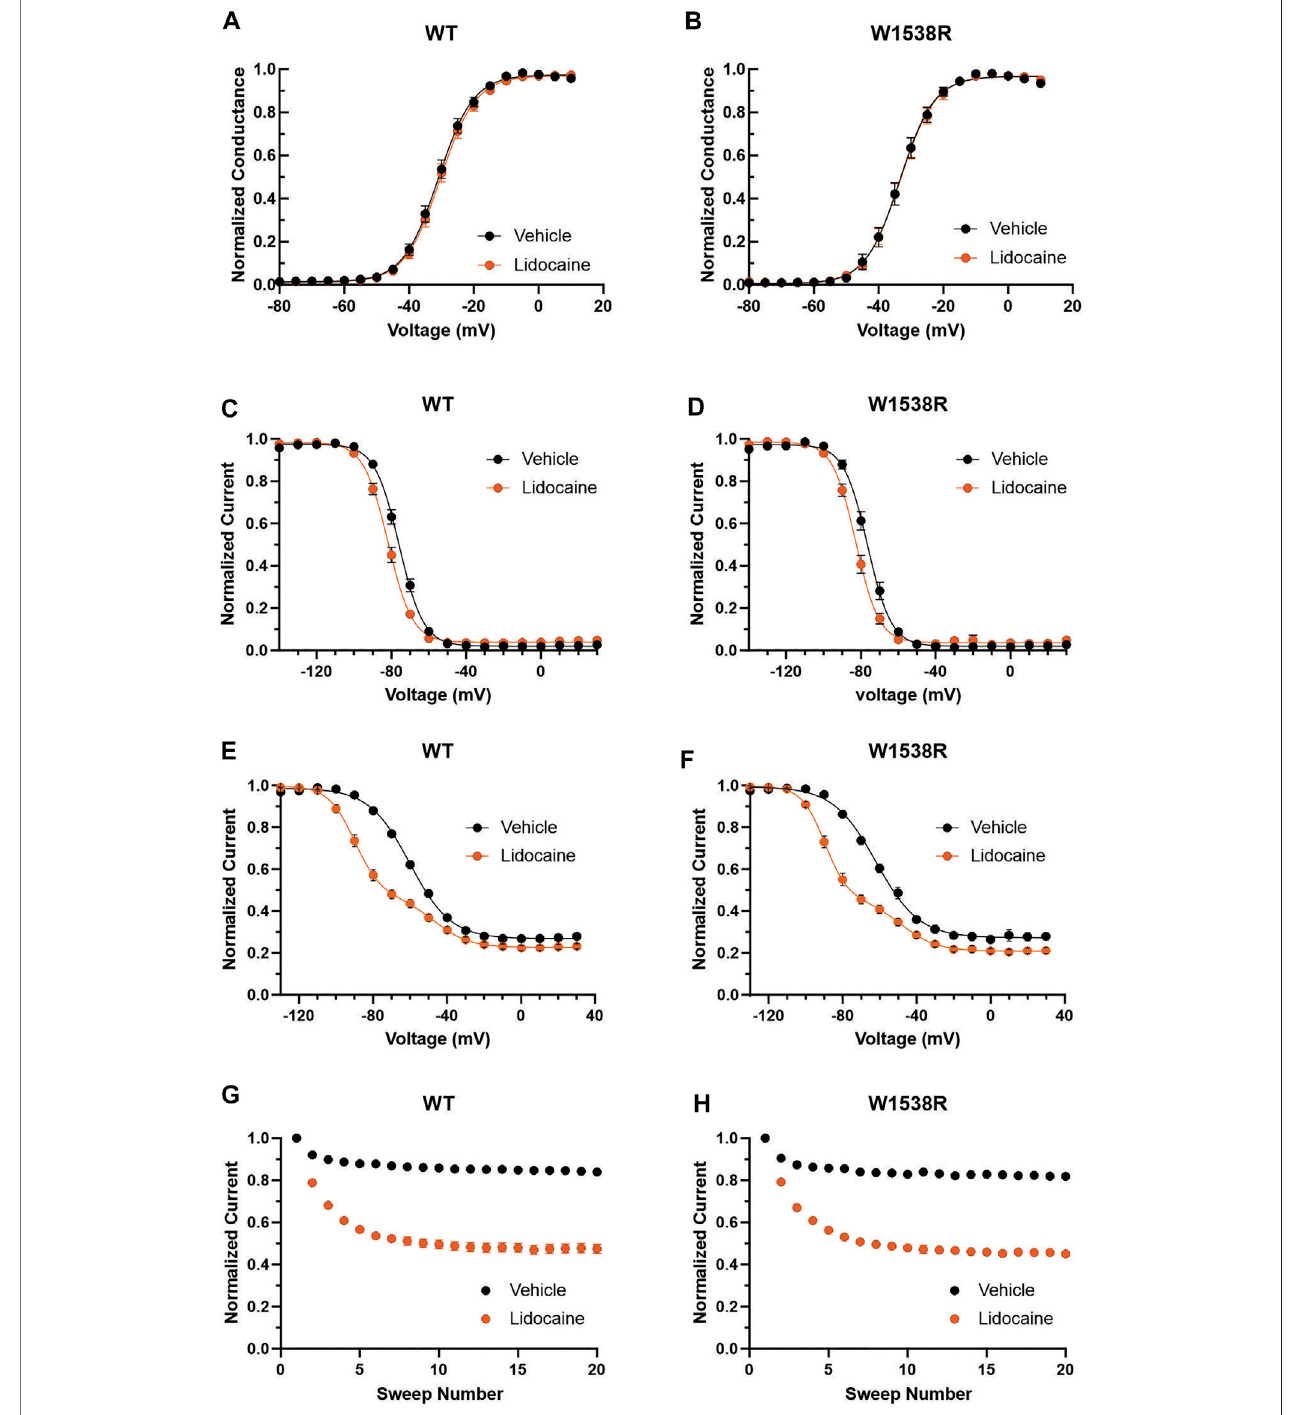
FIGURE3| LidocaineinhibitsNa V 1.7-W1538Rmutantchannels.Theeffectof80 μ Mlidocaineonthevoltage-dependenceofactivation,shownwithsingle(vehicle) and double (lidocaine) Boltzmann fi ts of normalized conductance transformed from the current-voltage plot peak inward currents, of (A) Na V 1.7-WT was indiscernible from (B) Na V 1.7-W1538R channels. (C,D) Relative to vehicle (extracellular bath solution, black), lidocaine (orange) hyperpolarizes the voltage-dependence of fast- inactivation of both Na V 1.7-WT and Na V 1.7-W1538R. (E,F) Lidocaine additionally hyperpolarizes the voltage-dependence of slow-inactivation of both Na V 1.7-WT and Na V 1.7-W1538R. (G,H) Lidocaine also enhances the use-dependent inhibition of Na V 1.7-WT and Na V 1.7-W1538R.